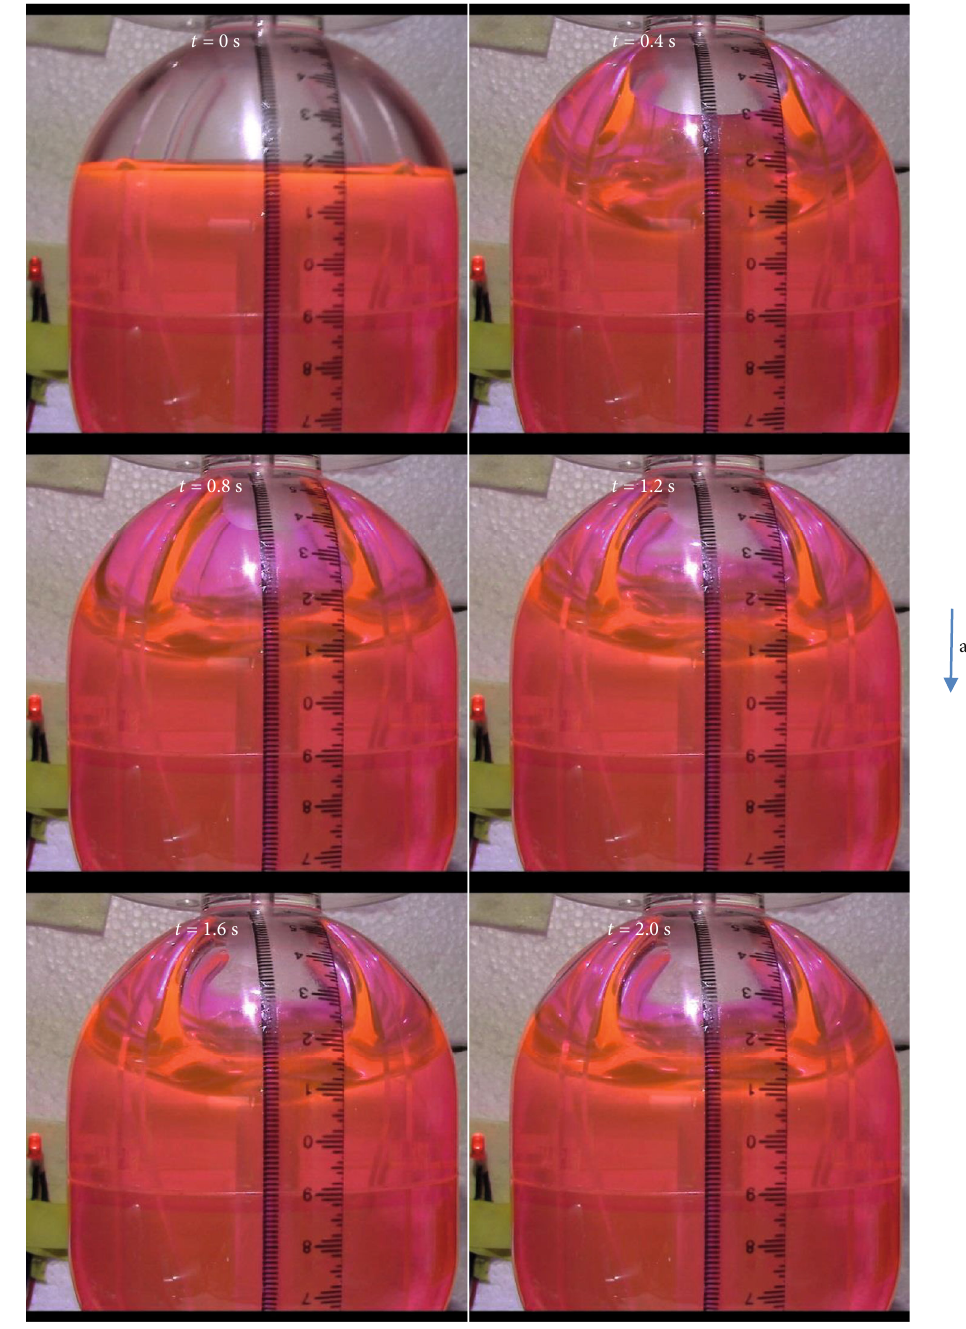
Figure 10: Liquid volume fraction is